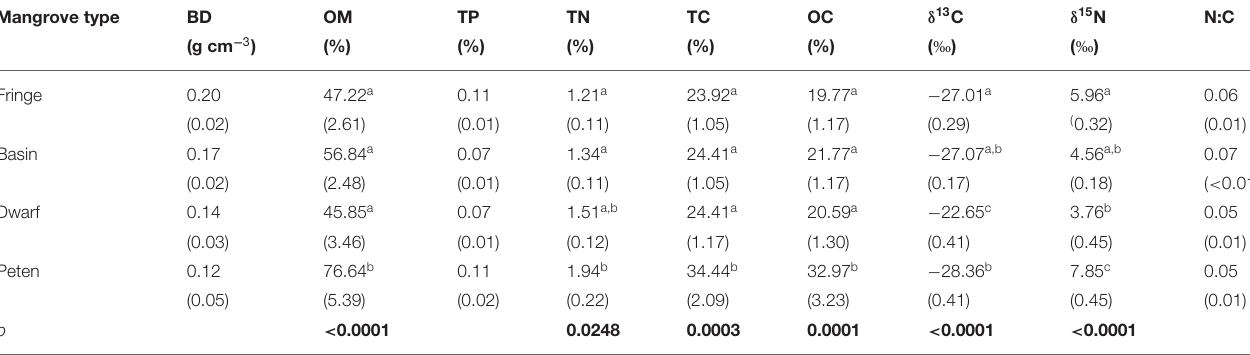
TABLE 2 | Characteristics of the sediments in four ecological types of mangroves. Mangrove